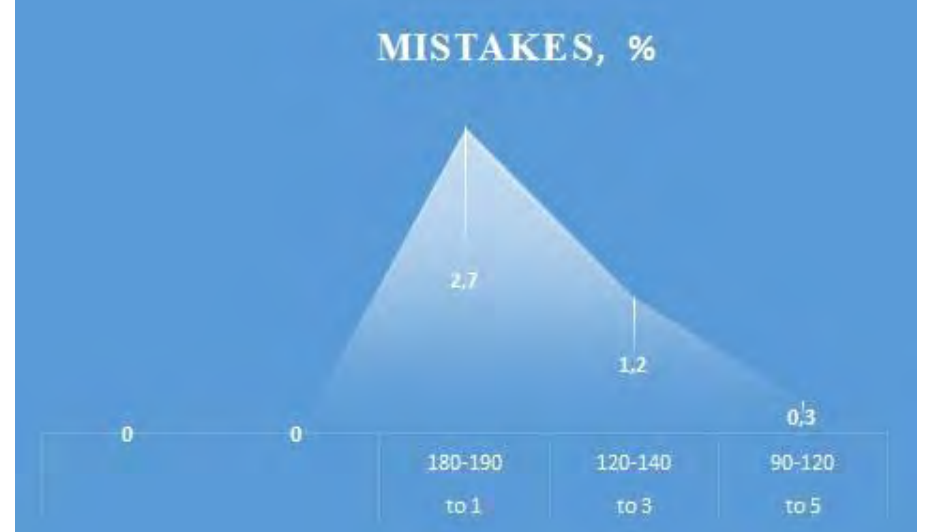
Fig. 2. Dynamic of mistakes depending on alternation of loads and rest of qualified handball